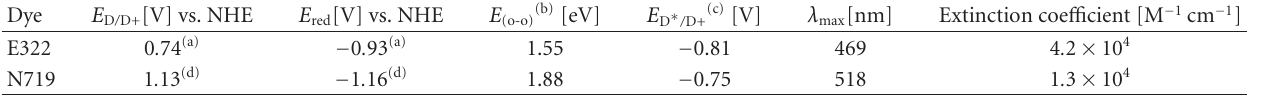
Table 1: Experimental data for electrochemical and spectral properties of the dyes.